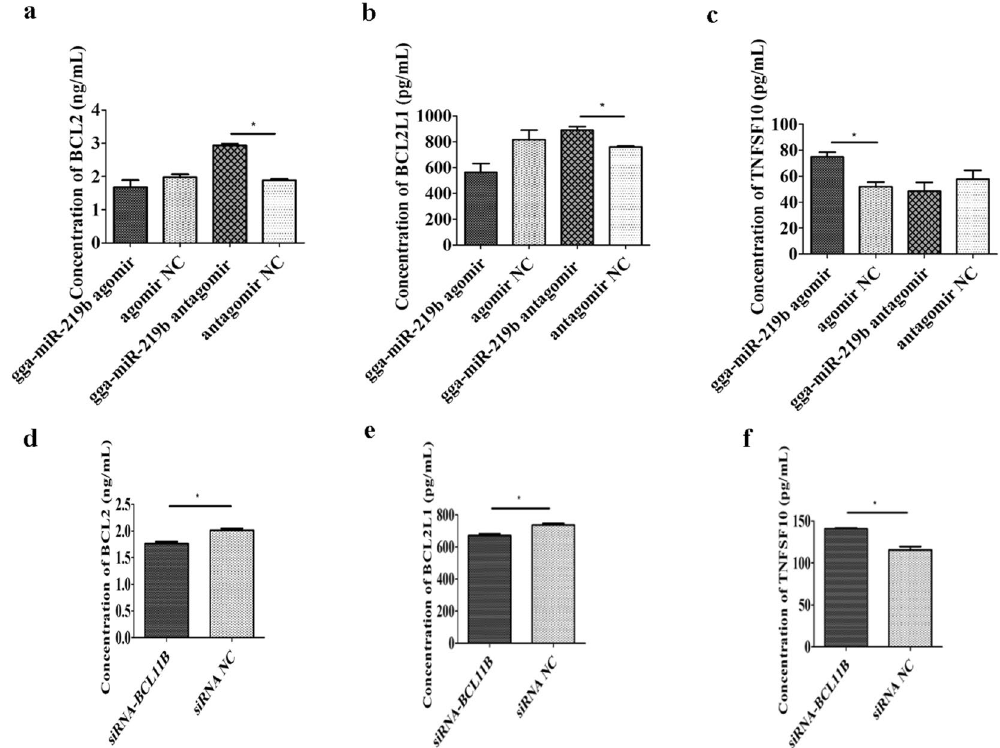
Figure 5. Effect of gga-miR-219b and BCL11B on gene expression at the protein level in the mitochondrial and death receptor pathways. ( a–c ) Protein level of BCL2 ( a ), BCL2L1 ( b ) and TNFSF10 ( c ) in the apoptosis pathways by ELISA after transient transfection with the gga-miR-219b agomir, antagomir or respective NC at 48 h (n = 3). ( d–f ) Protein level of BCL2 ( d ), BCL2L1 ( e ) and TNFSF10 ( f ) in the apoptosis pathways by ELISA after transient transfection with siRNA-BCL11B and siRNA NC at 48 h (n = 3). Differences between two groups were analysed by Student’s t -test with the SAS system. The data are expressed as the mean ± S.E. * P < 0.05. ** P < 0.01.